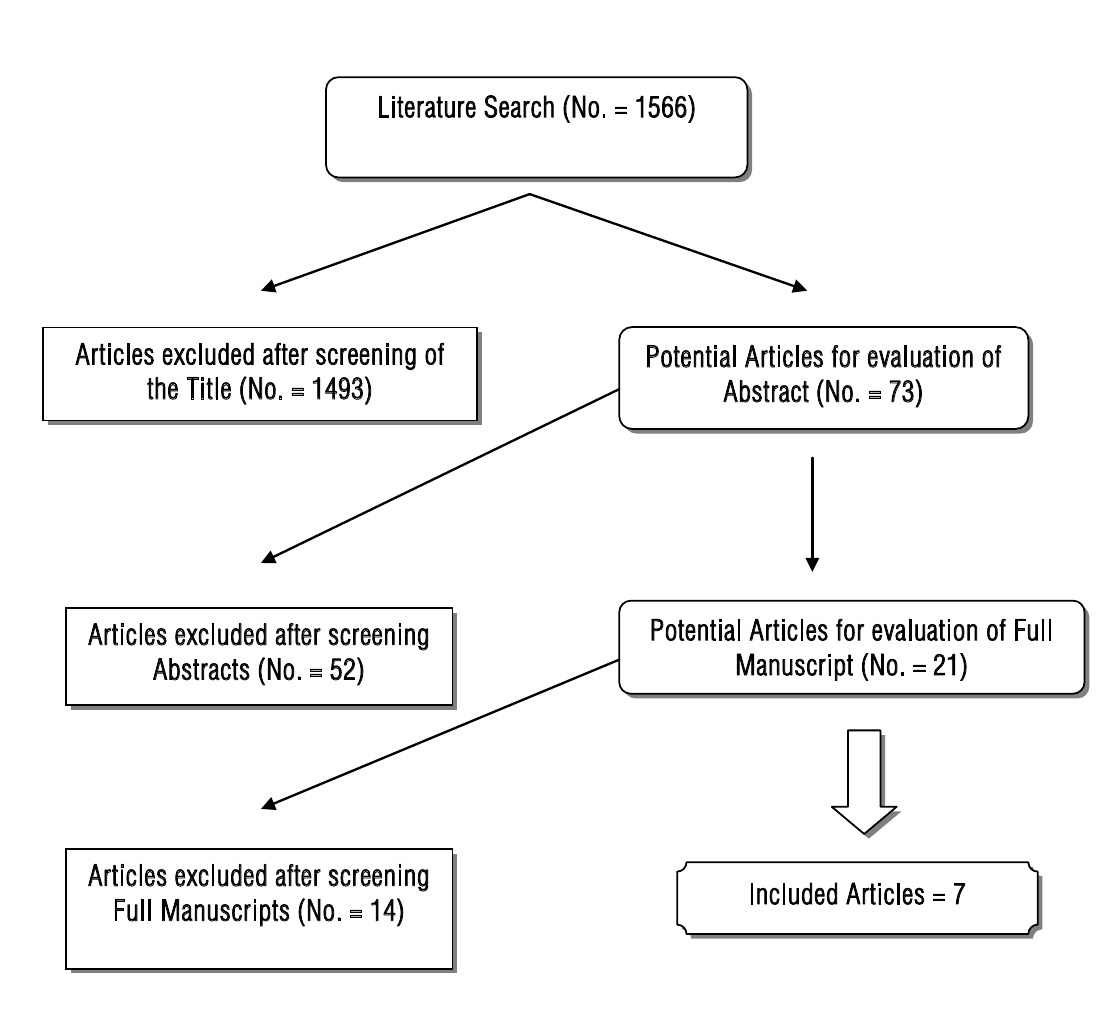
figure 1 - flowchart for literature